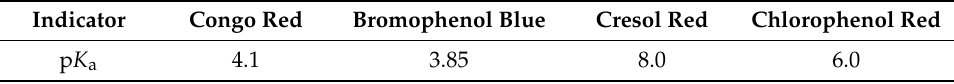
Table 6. Acid dissociation constant (p K a ) of the four indicators.